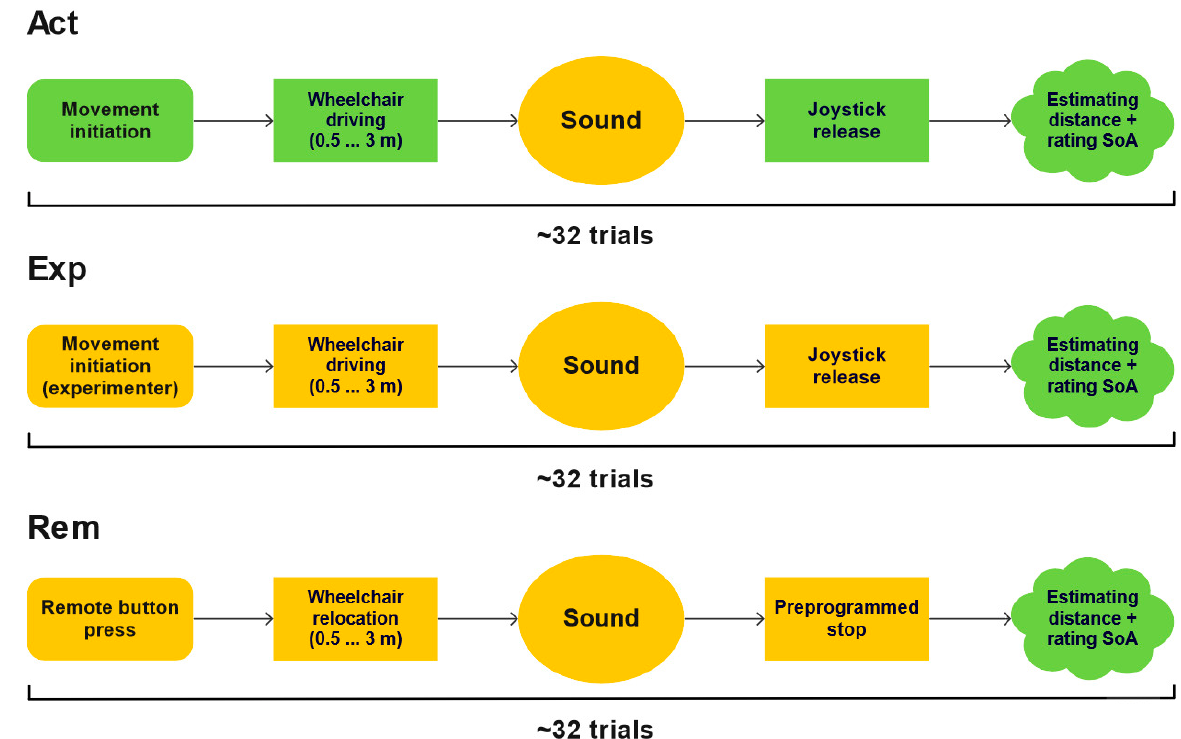
Figure 2. Flowchart of the experimental procedure in different conditions. The color indicates the degree of the participant ’ s control over events (green—direct control, orange—no direct control) .